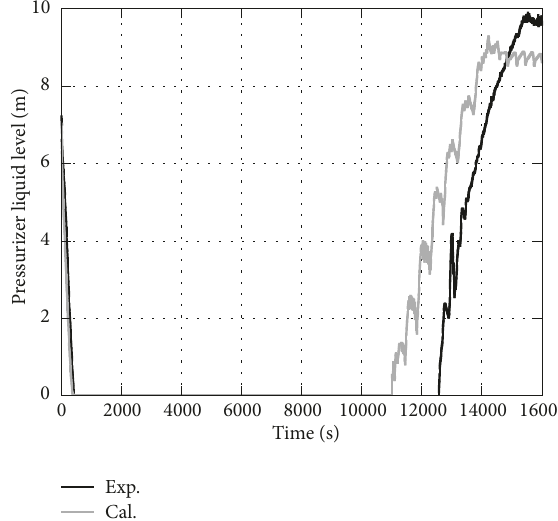
Figure 30: TR-LF-16 test and RELAP5 results for PZR liquid